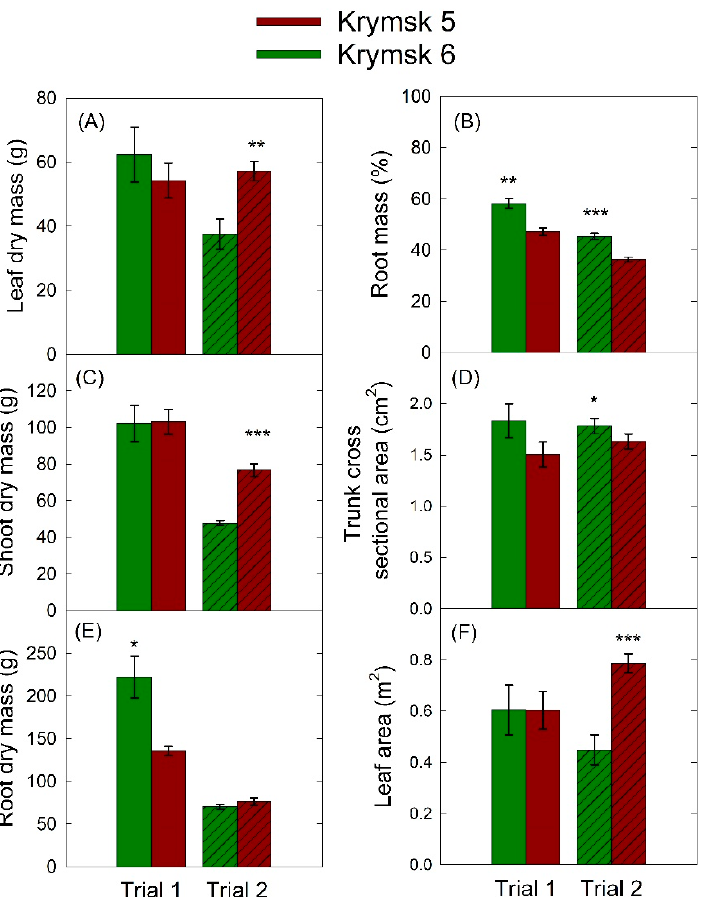
Figure 3. Selected average destructive harvest parameters: ( A ) leaf dry mass, ( B ) percentage root mass, ( C ), shoot dry mass, ( D ) trunk cross-sectional area, ( E ) root dry mas, and ( F ) leaf area for rootstocks Krymsk ® 5 ( red ) and 6 ( green ) over the course of two trials in which drought was imposed using a 16-cell lysimeter system. Each load cell was independently controlled, and when cumulative transpiration fell below 75% of peak transpiration for the first trial, and 70% for the second trial, irrigation was triggered. Bars represent standard error from 8 replicate trees. *** p < 0.001; ** p < 0.01; * p < 0.05.